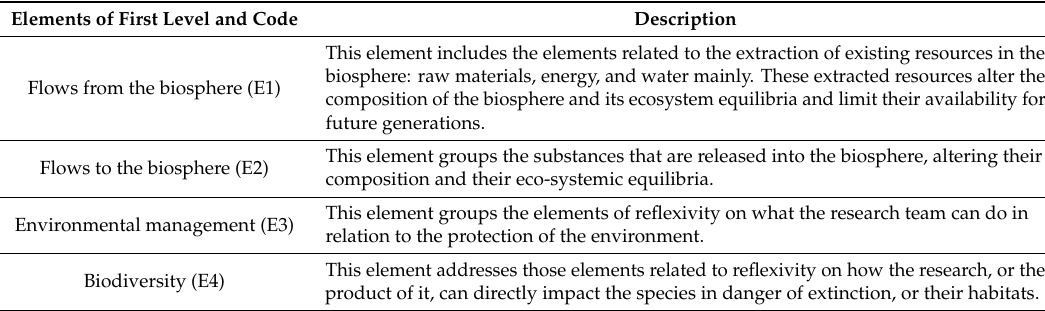
Table A2. Description of the elements of the first level.